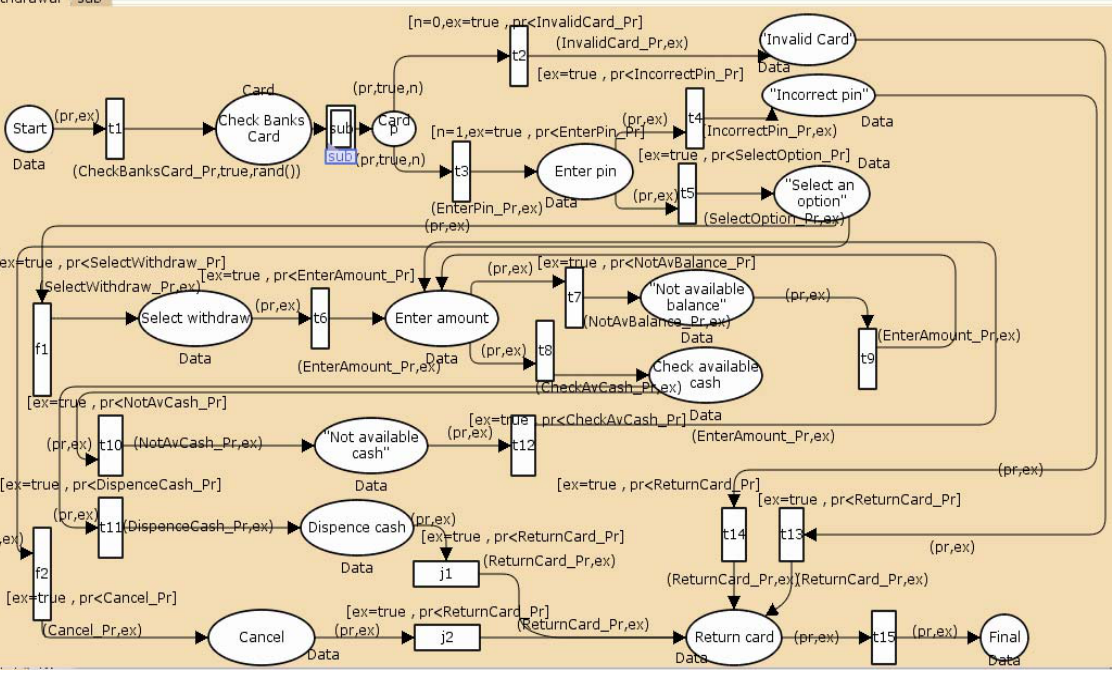
Fig. 16. CPN with transition